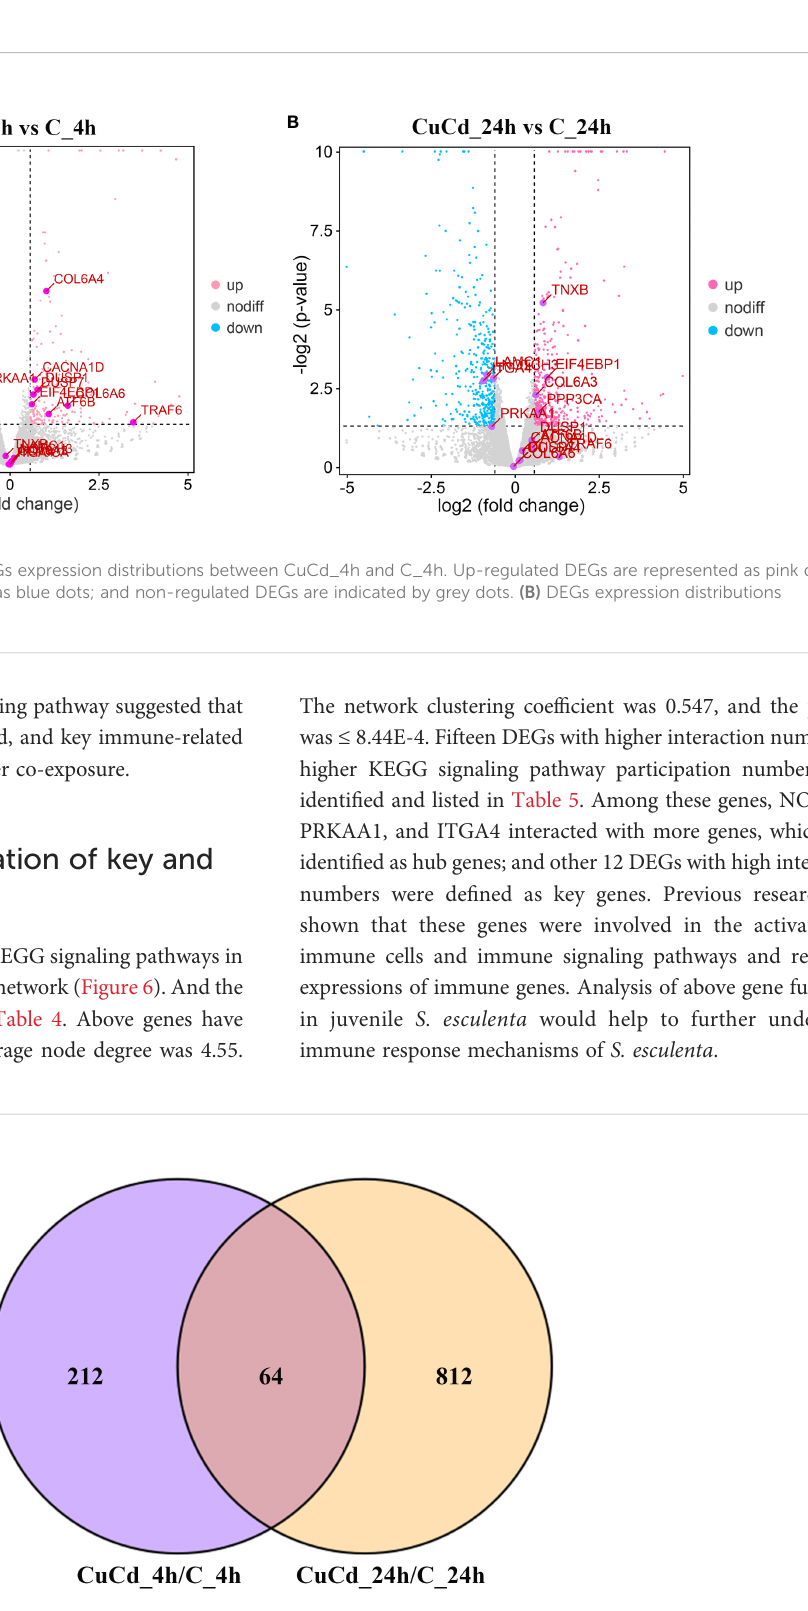
FIGURE 2 DEGs distributions between two time point. 1,088 DEGs are differential expressed at 4 and 24 h after exposure. 212 DEGs are differential expressed only at 4 h; 812 DEGs are differential expressed only at 24 h; 64 DEGs are differential expressed at both 4 and 24 h.